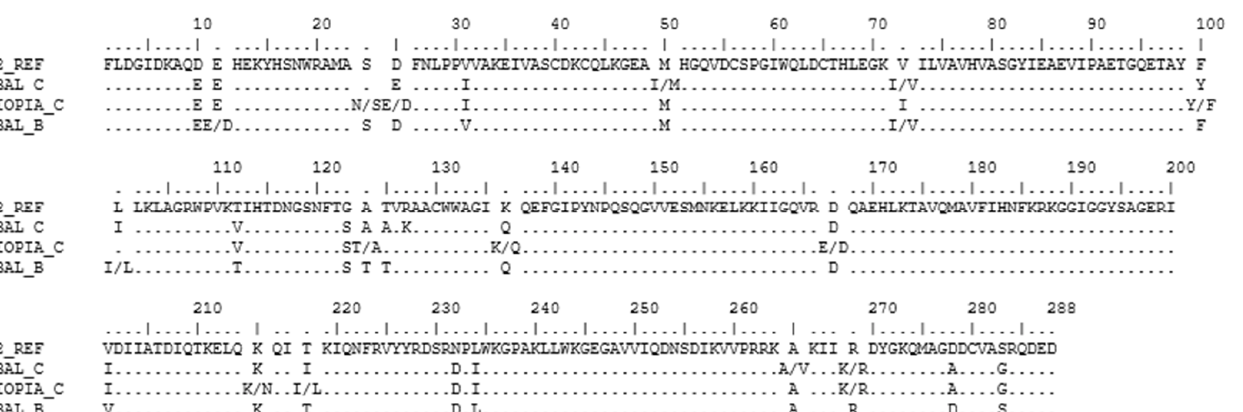
Table 2. Analysis of genetic barrier based on the minimum number of transitions and transversions required to obtain mutation resistance to DTG.